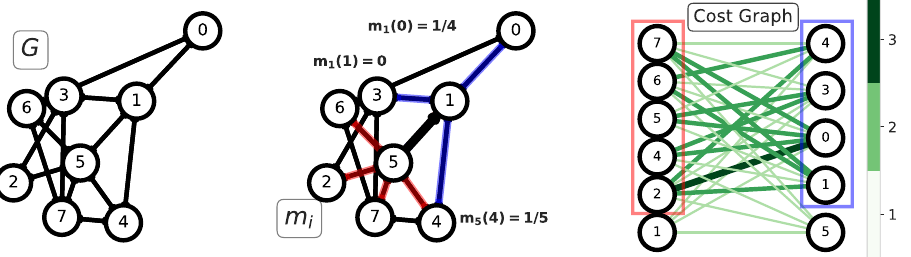
Figure 1. Left: an example graph G where edges have unitary weights. Center: the edge (1, 5) (bold black line) is selected to define the OT problem between m 1 , m 5 ; neighborhoods of nodes 1 and 5 are highlighted with blue and red edges and are used to build the corresponding distributions m 1 , m 5 . Right: The complete bipartite graph B 15 where the OT problem is defined. The color intensity of the edges represents the distance between the associated nodes on the graph G , as shown by the color bar. m 1 and m 5 are both defined for α = 0, i.e. no mass is left in 1 and 5.